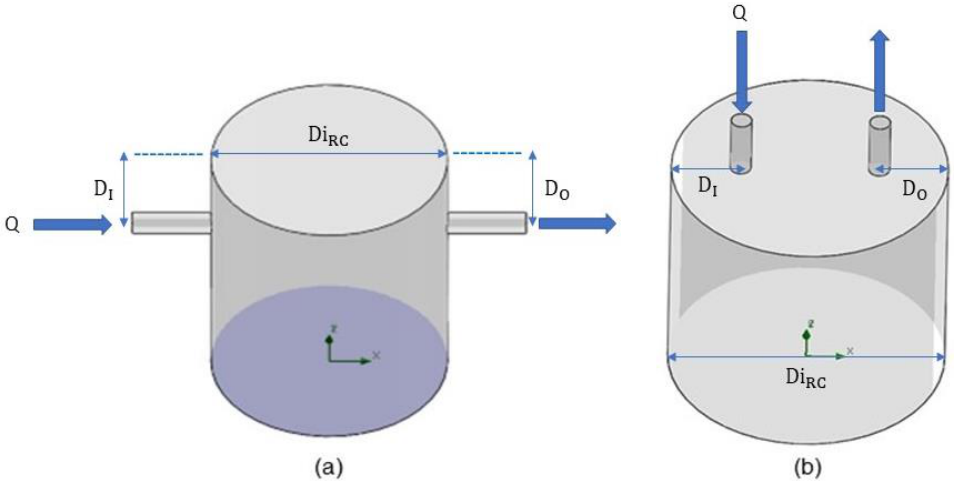
Figure 2. Conceptual model of reaction cell with air inlet and outlet ( a ) in the lateral region and ( b ) in the upper region.